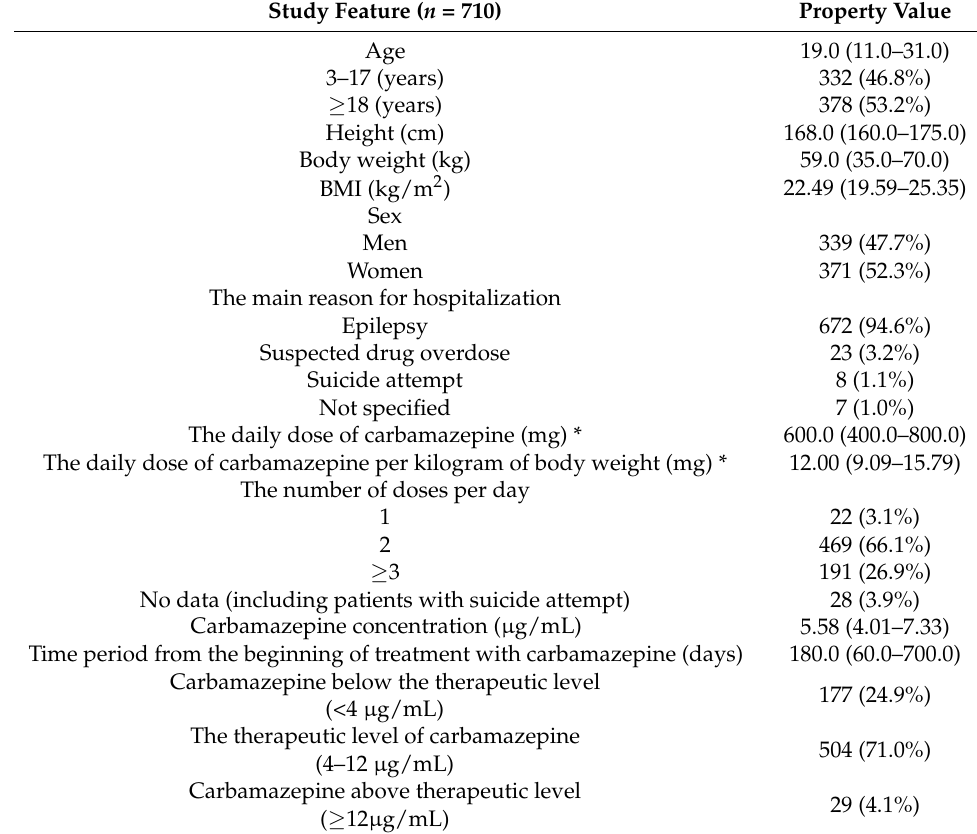
Table 1. Clinical characteristics of the study population (median (lower quartile–upper quartile) or number